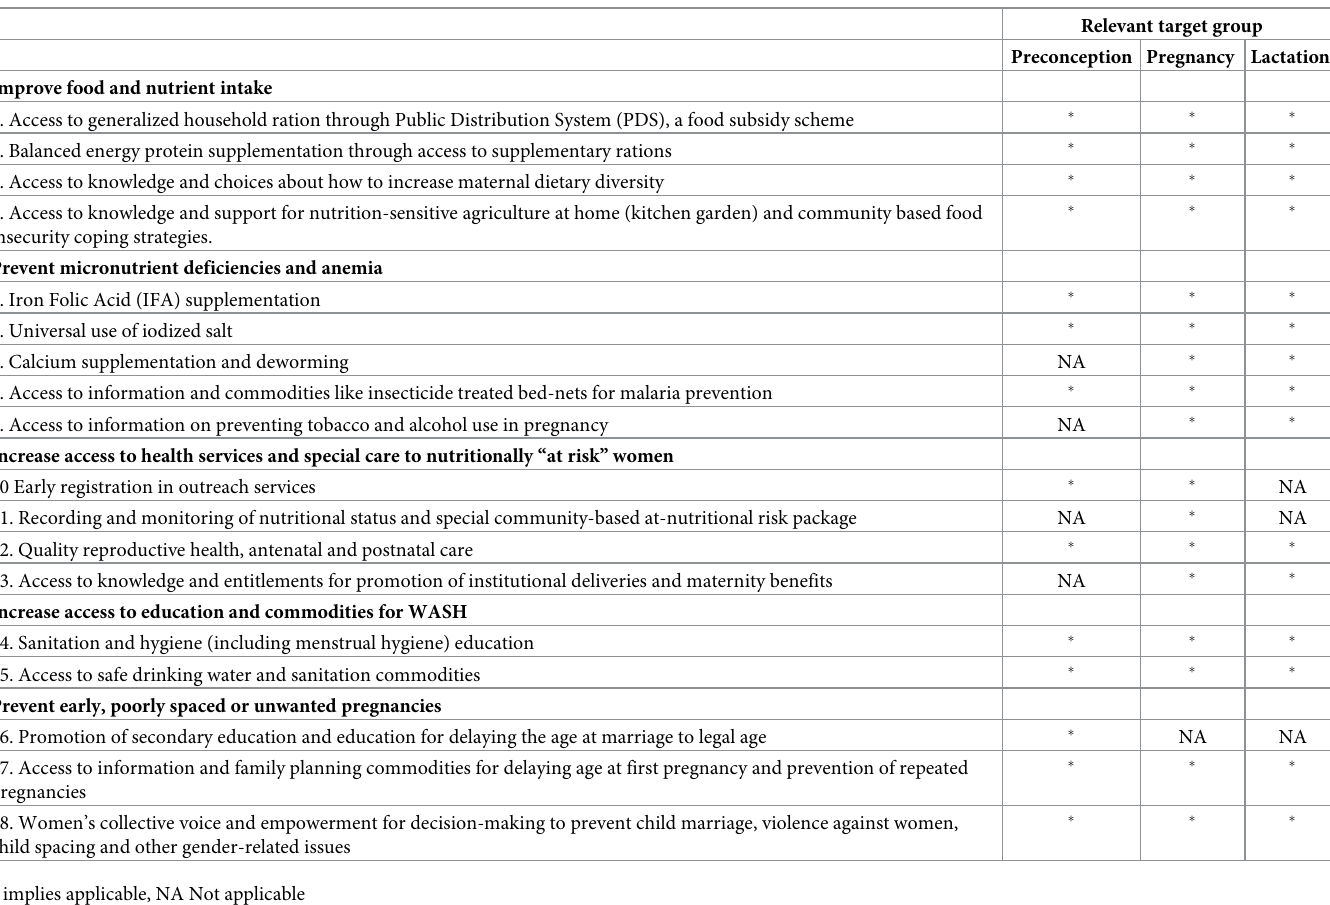
Table 2. Nutrition-specific and nutrition-sensitive interventions package, Swabhimaan.